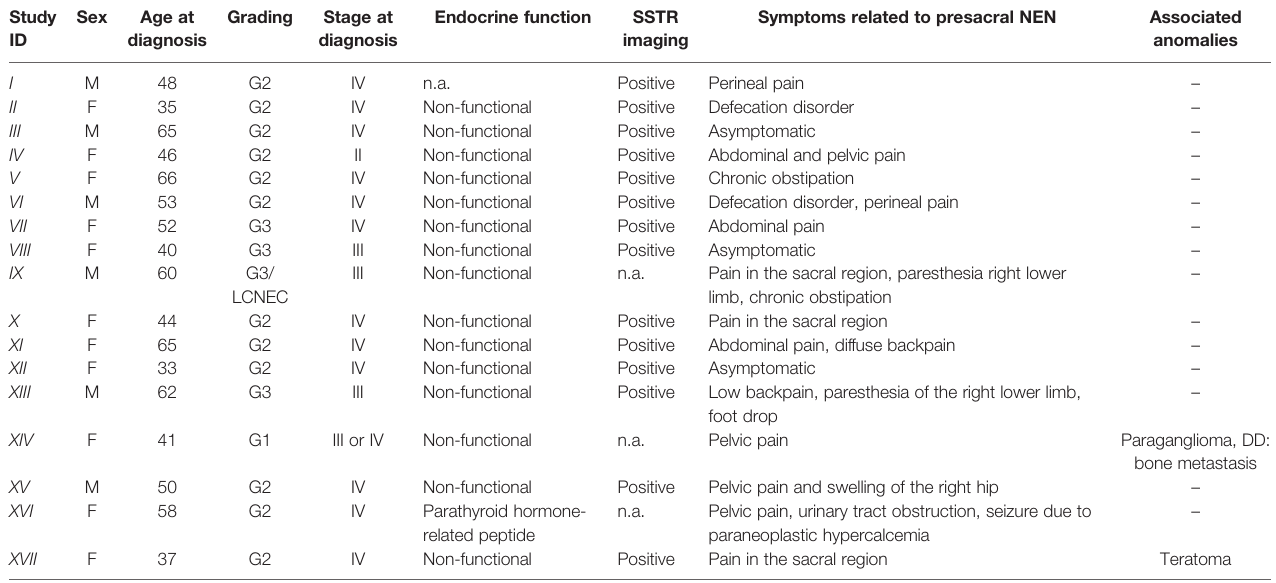
TABLE 1 | Patient